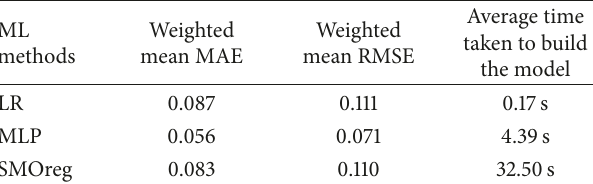
Table 5: Experimental results for 5,000 samples.